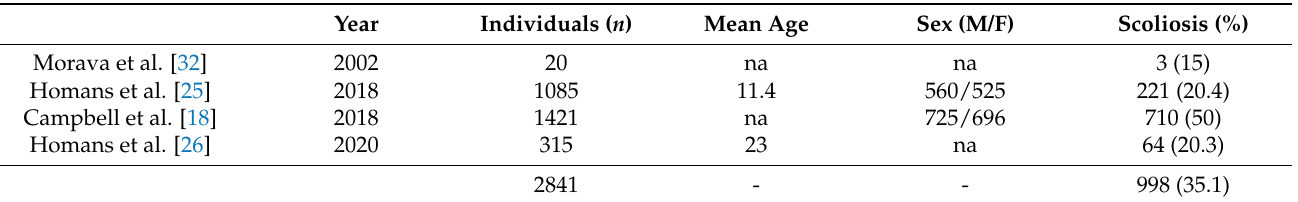
Table 1. Analysis of the current literature for individuals with 22q11.2 deletion syndrome and scoliosis.